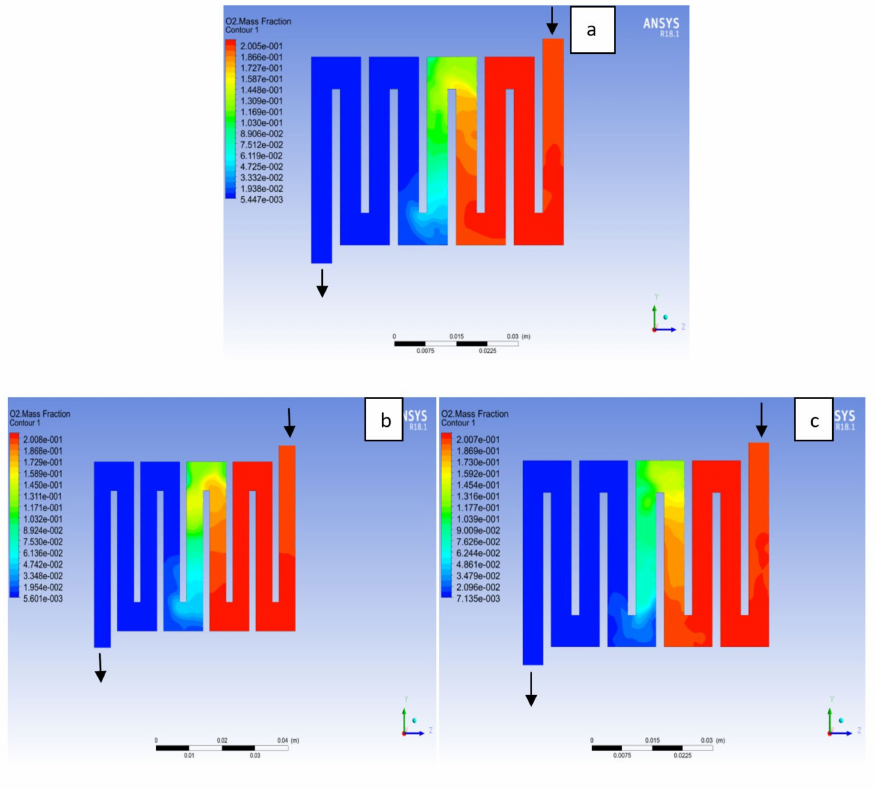
Figure 17. Contours of oxygen mass fraction at the cathode region (GDL/CL) for each material with temperature 323 K at pressure 1.5 bar: ( a ) Aluminum, ( b ) Copper, ( c )